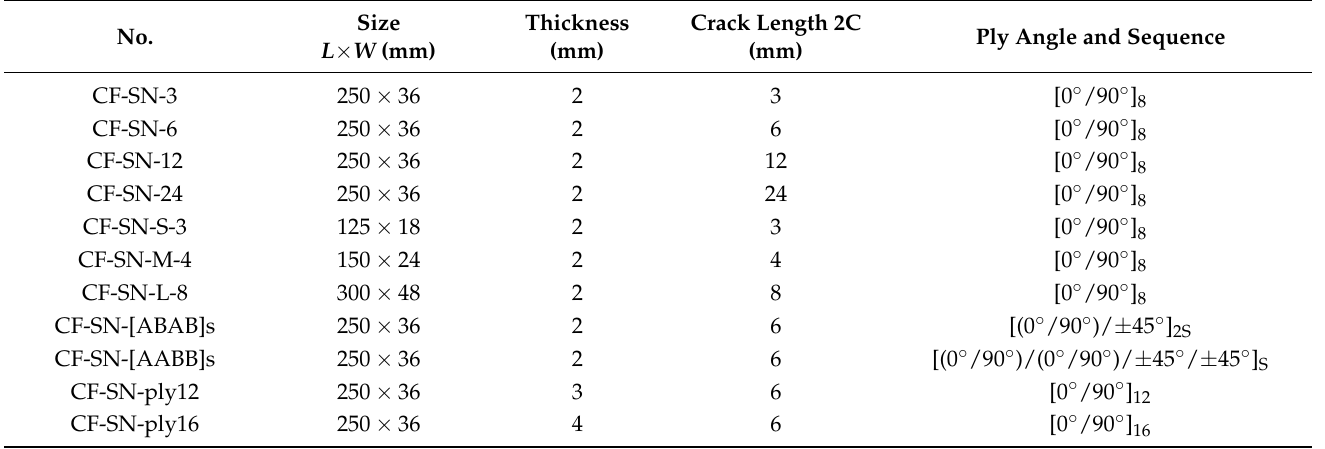
Figure 3. Specimen and configuration. ( a ) Equal specimen size group; ( b ) equal ratio of W /2 C group; ( c ) different lay-up sequence group; and ( d ) different laminated thickness group. CF stands for carbon-fiber-reinforced composite; SN represents a straight notch; the following number stands for the notch size; letter A represents the normal woven fabric orthogonal lay-up; and letter B represents the 45 ◦ -oriented lay-up of the plate mold. Table 1. Finite-width specimens for experimental